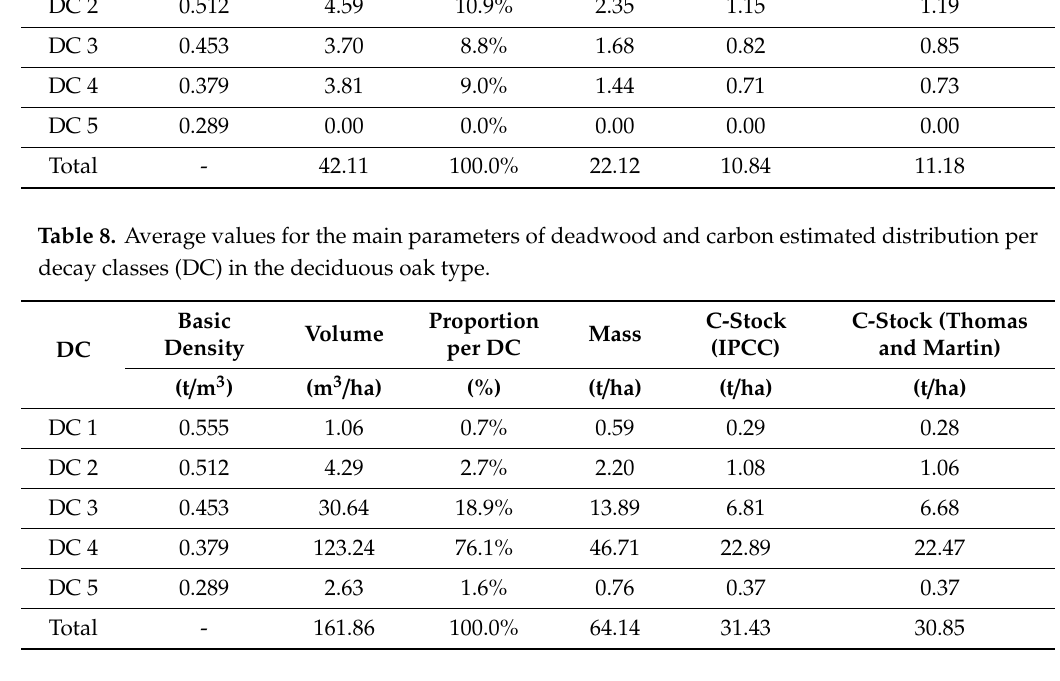
Table 8. Average values for the main parameters of deadwood and carbon estimated distribution per decay classes (DC) in the deciduous oak type.